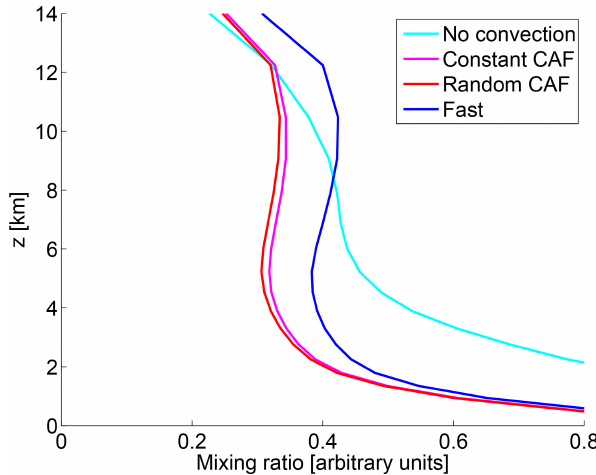
Figure 18. Mean simulated artificial SO 2 -like tracer profiles in the tropics (30 ◦ S–30 ◦ N) for a run without convection, a run with a constant convective area fraction profile, a run with a random con- vective area fraction profile and a run for which the vertical updraft velocity is set to a constant value of 100ms − 1 to mimic the redistri- bution within a short fixed time step in other Lagrangian convective transport